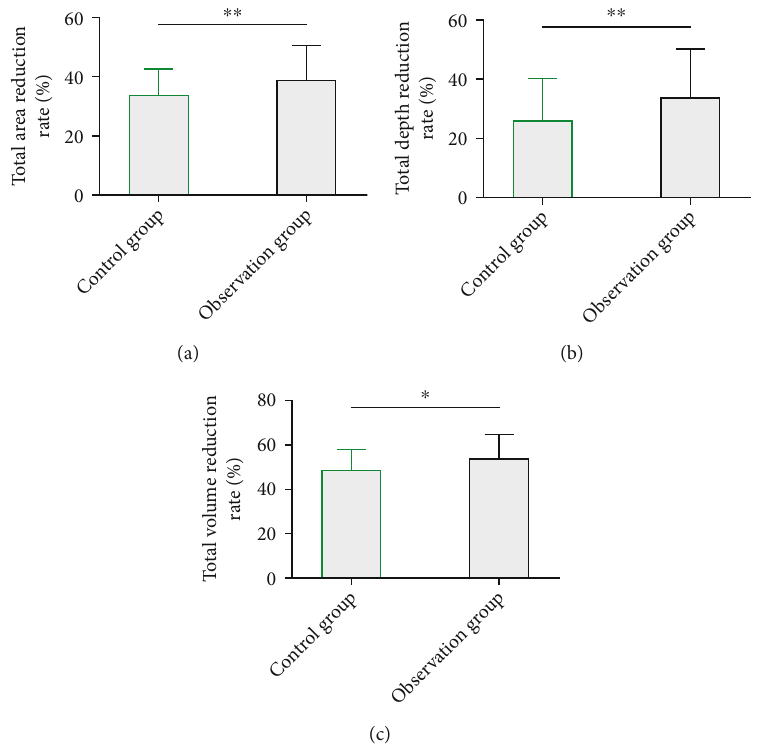
Figure 1: PU alleviation in the two groups. (a) The observation group showed a statistically higher total area reduction rate than the control group. (b) The observation group showed a statistically higher total depth reduction rate than the control group. (c) The observation group showed a statistically higher total volume reduction rate than the control group. Note: ∗ P < 0 : 05 ; ∗∗ P < 0 : 01 .